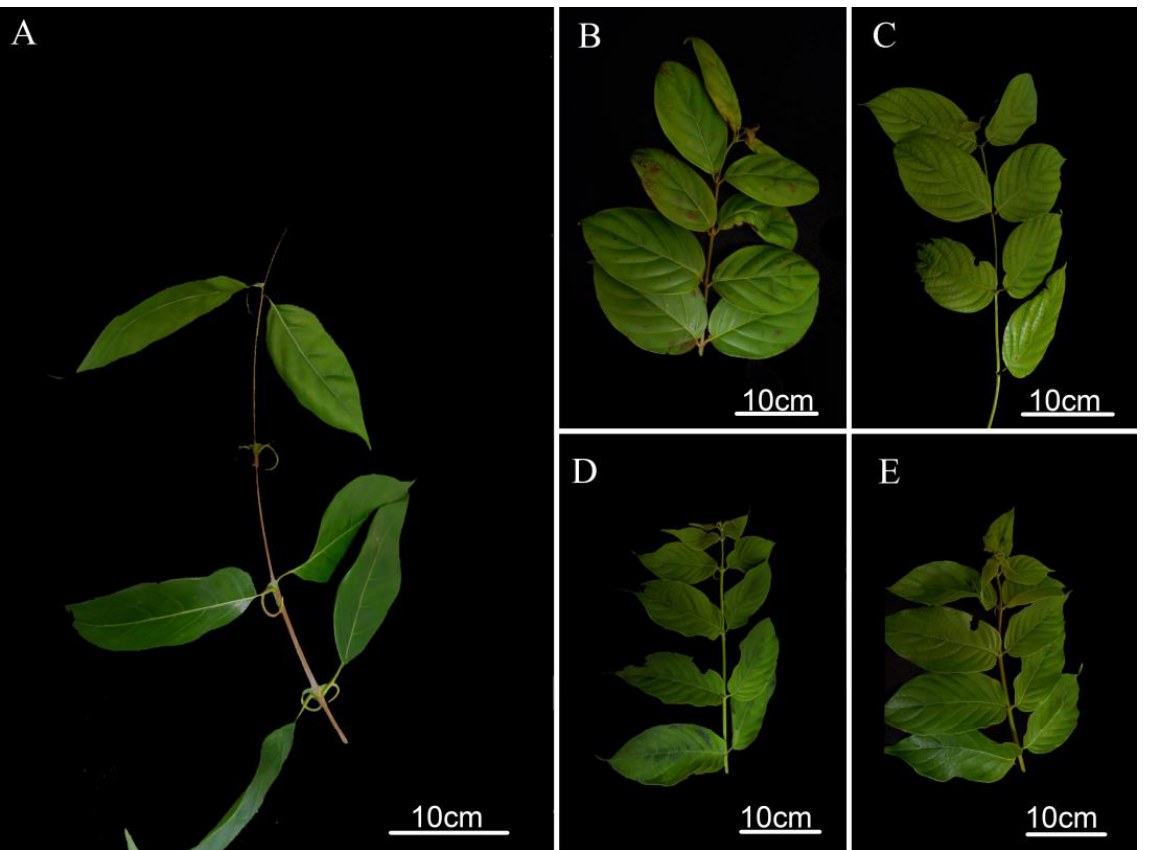
Figure 1. The leaf characteristics of five species in Uncaria. ( A ): U. rhynchophylla; ( B ): U. sessilifructus; ( C ): U. macrophylla; ( D ): U. hirsuta; ( E ): U. scandens.